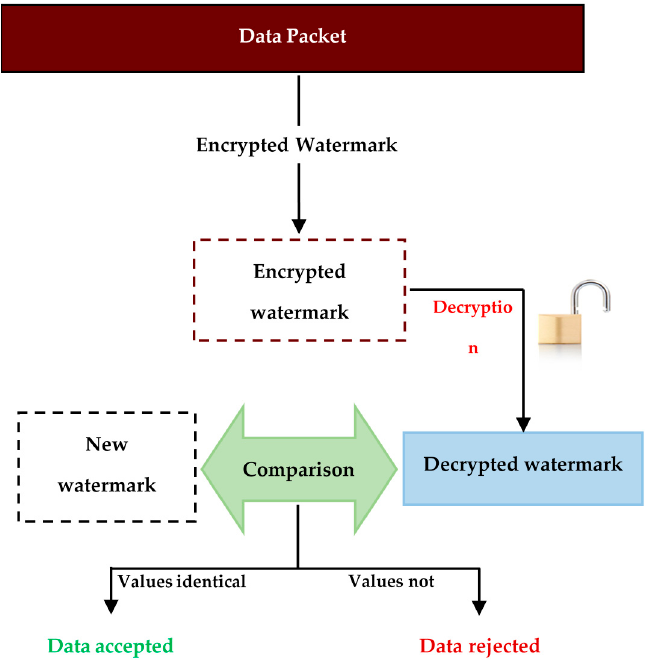
Figure 10. CLDWA extraction and verification (the heterogeneous nodes level).